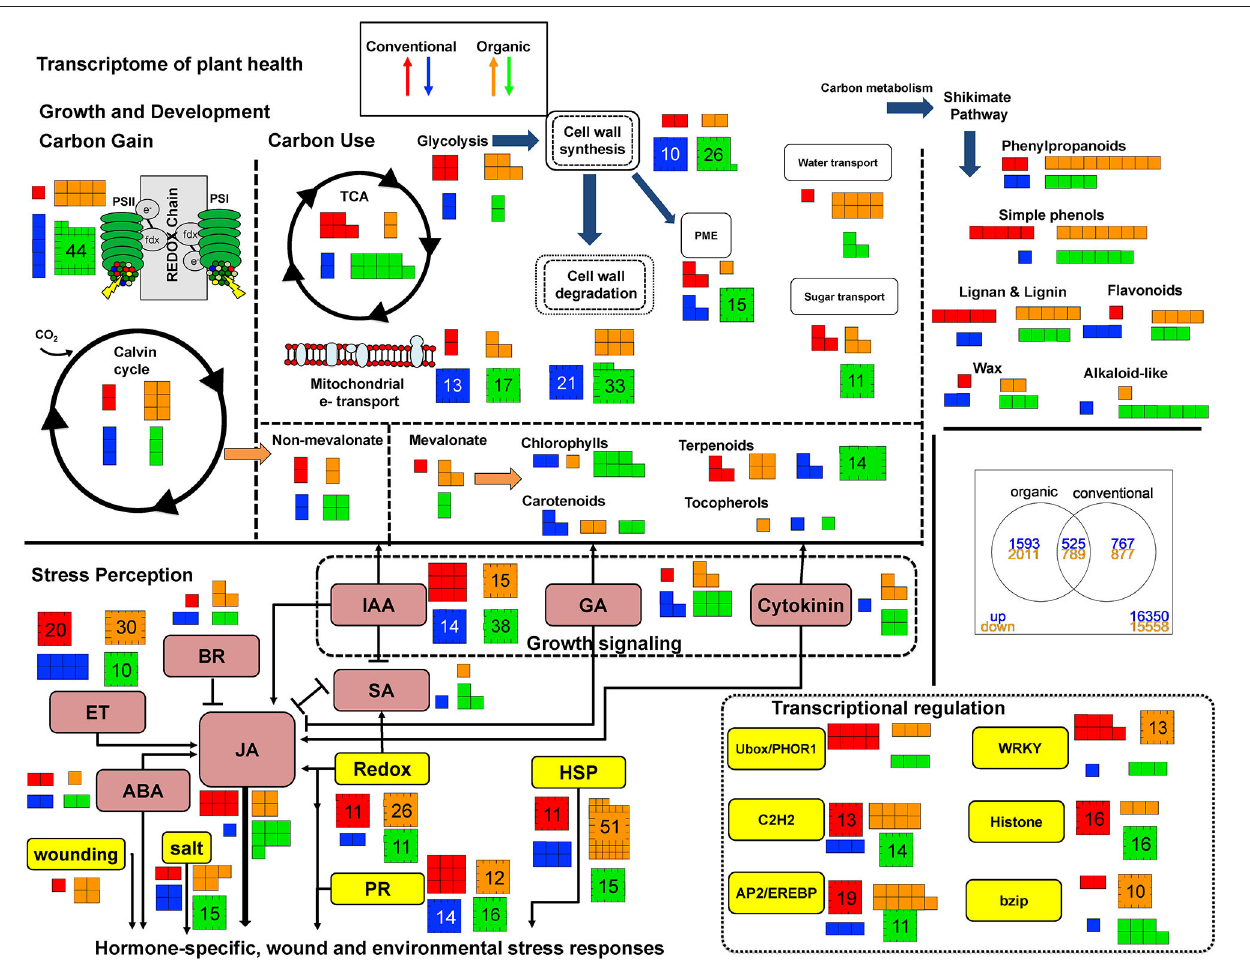
FIGURE 1 | This graphical representation of the transcriptome for processes related to plant health and defense compares Norkotah potato plants grown under organic (orange and green arrows) and conventional (red and blue arrows) farming methods between insect undamaged and damaged leaves. Genes up or down are in reference to how plants respond to damage under different management regimes. Numbers indicate how many genes are up or down regulated. Text containing boxes are colored coded for metabolites specifically involved in hormone signaling/perception: pink; and non-hormonal processes mediating stress response/perception: yellow. Arrows link flow from primary to secondary metabolism (Top) and synergistic or antagonistic signaling during stress perception (Bottom) .